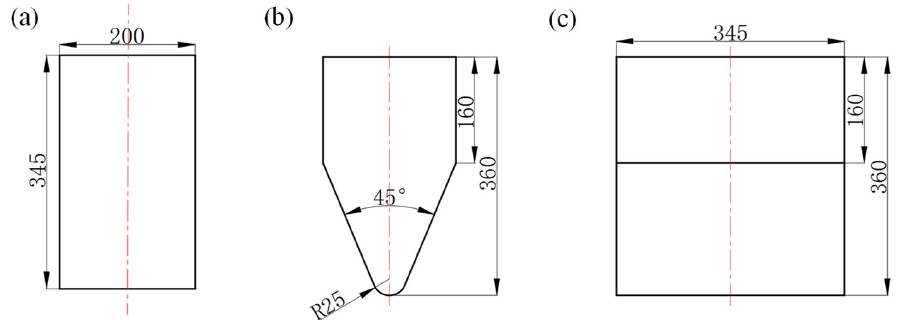
Figure 4. The shape of the ice indenter and its dimensions (Unit: mm): ( a ) Top view; ( b ) Side view; ( c ) Front view.